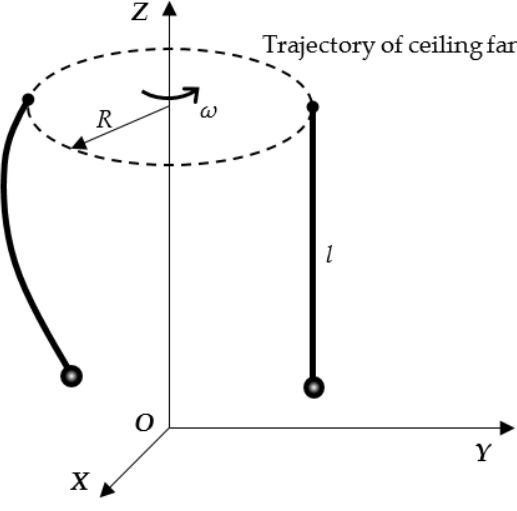
Figure 10. Scheme of circularly towed cable